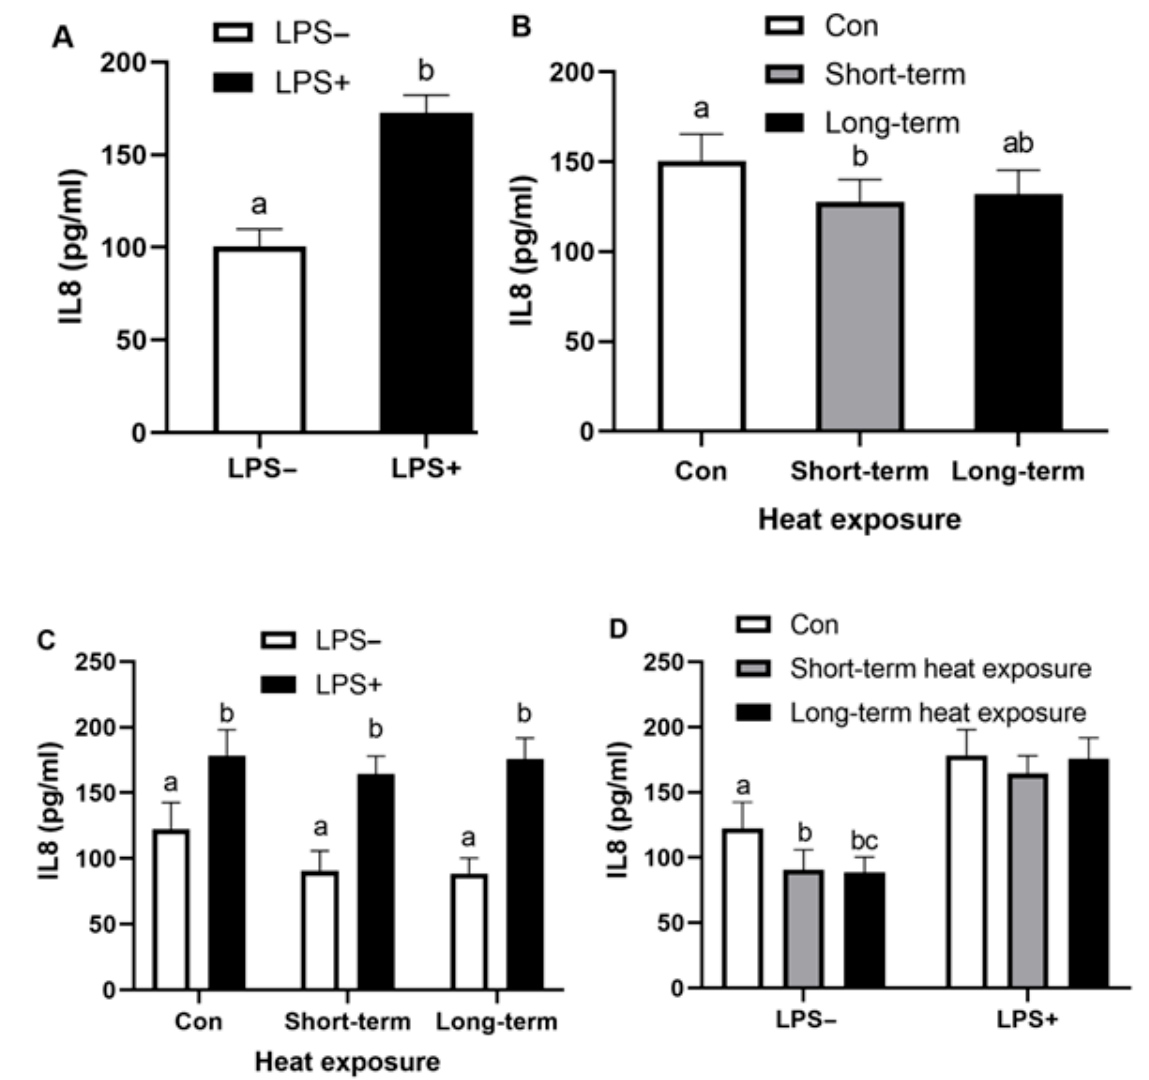
Figure 3. Secretion of IL8 (pg/mL) in the medium of bovine endometrial cells cultured in the presence or absence of 100 ng/mL LPS with different heat exposure (control: Con; short-term heat exposure; long-term heat exposure). Treatments were replicated three times, and the experiment was conducted on four separate occasions. Different superscripts indicate significant differences (p < 0.05), as determined by mixed model analysis using two fixed factors—LPS treatment ( A ) and heat exposure ( B )—followed by Bonferroni post hoc test ( C , D ). Values are mean ± SEM.